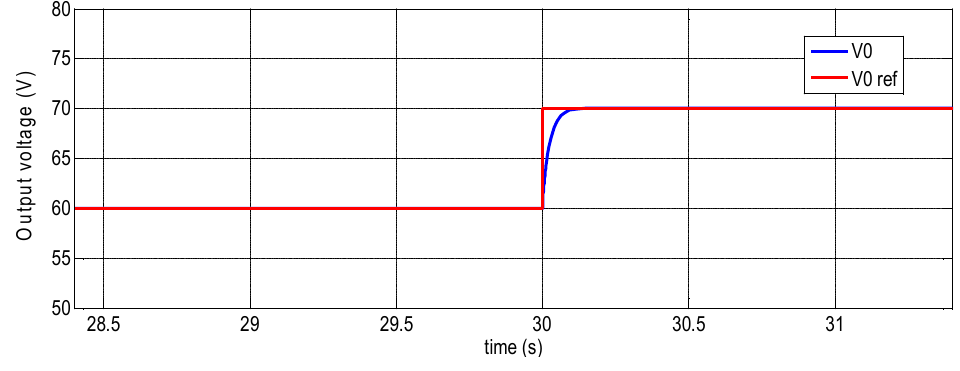
Figure 21. Closed loop system response.